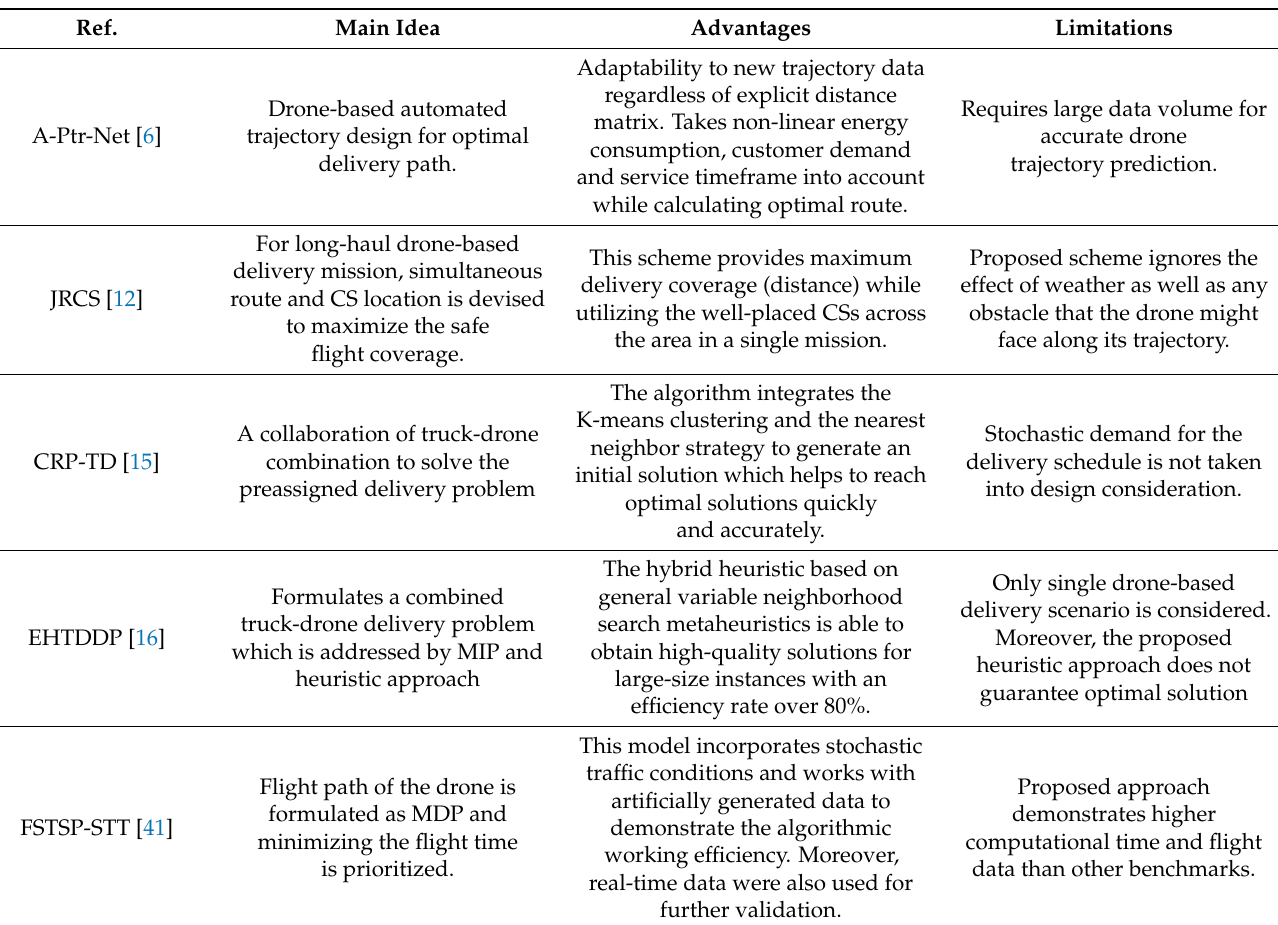
Table 2. Comparison of trajectory planning algorithms in drone routing in terms of main idea, advantages, and